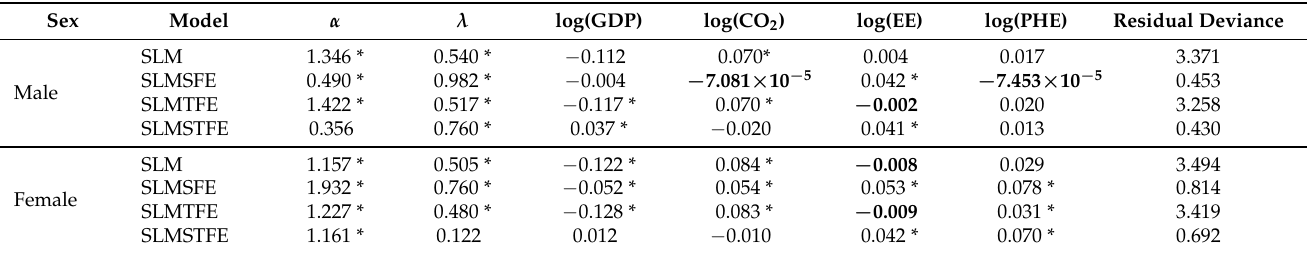
Table 4. Model fittings using the glm function in R by